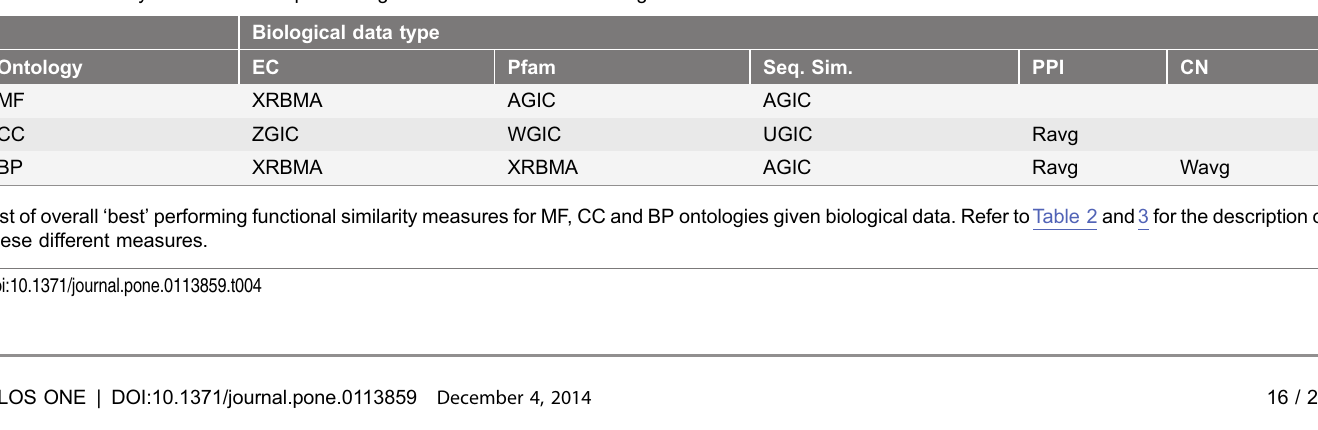
Table 4. Summary of overall ‘best’ performing measures for different biological